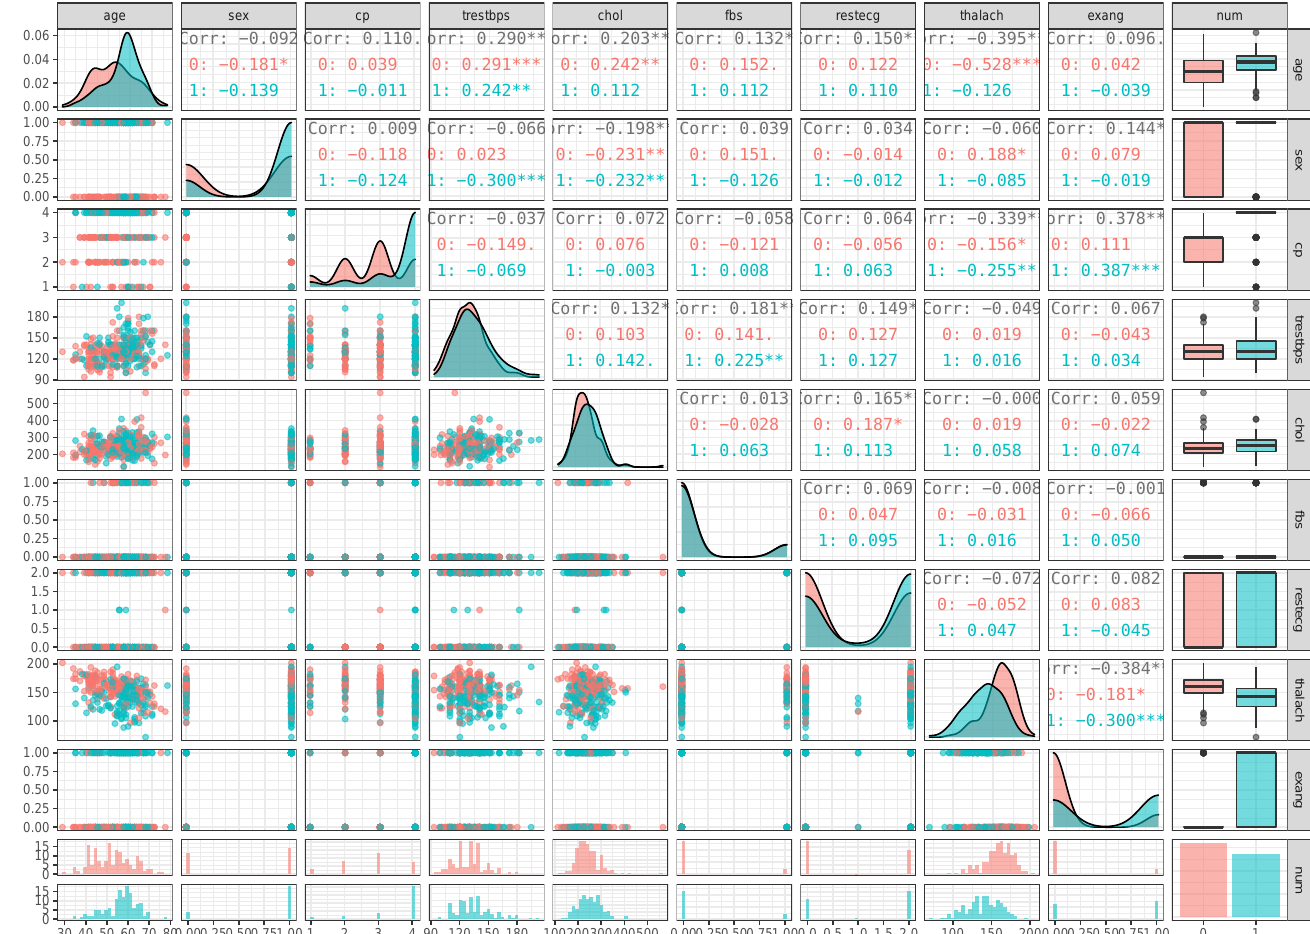
Figure 5. Scatter plot and correlation between variables by response in heart disease